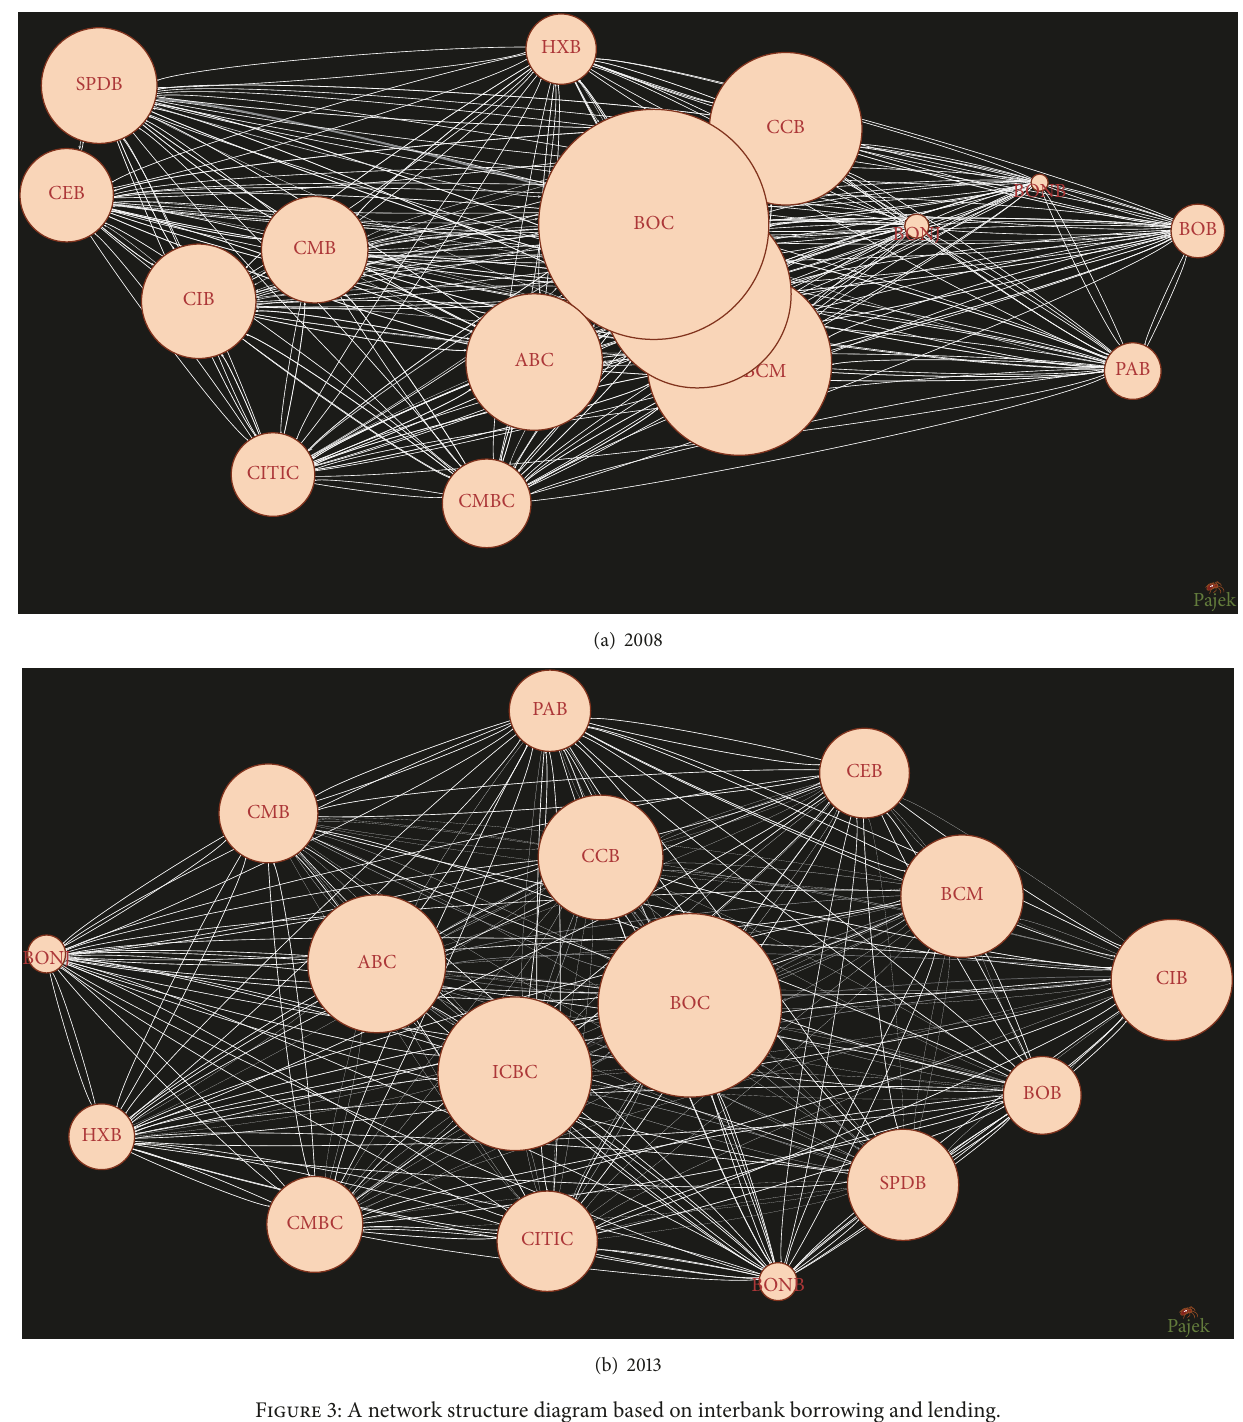
Figure 3: A network structure diagram based on interbank borrowing and